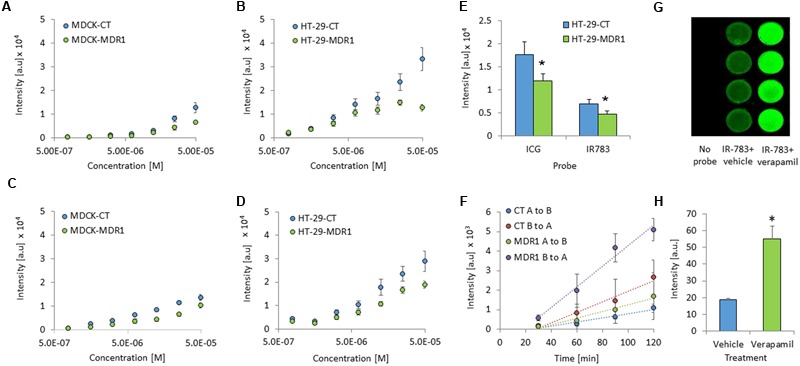
In vitro cellular accumulation of ICG and IR-783 in MDR1 and control cells. (A) ICG accumulation in Madin–Darby canine kidney (MDCK)-CT and MDCK-MDR1 cells. (B) ICG accumulation in HT-29-CT and HT-29-MDR1 cells. (C) IR-783 accumulation in MDCK-CT and MDCK-MDR1 cells. (D) IR-783 accumulation in HT-29-CT and HT-29-MDR1. Cells were incubated for 1 h with the indicated concentrations of the tested compound (n = 16 per each concentration). (E) ICG and IR-783 accumulation in HT-29 cells at 1.25 × 10-5 M (mean ± SD). Fluorescence intensity is presented as arbitrary units (a.u). (F) Transfer of IR-783 across MDCK-CT and MDCK-MDR1 cell monolayers. (G) An image of control MDCK cells incubated with IR-783 (2 × 10-5 M) at the presence or the absence of verapamil (200 μM). The experiment was repeated twice, on two different days. (H) Emission intensity of control MDCK cells following incubation with IR-783 as described for (G; n = 8). ∗p < 0.01.